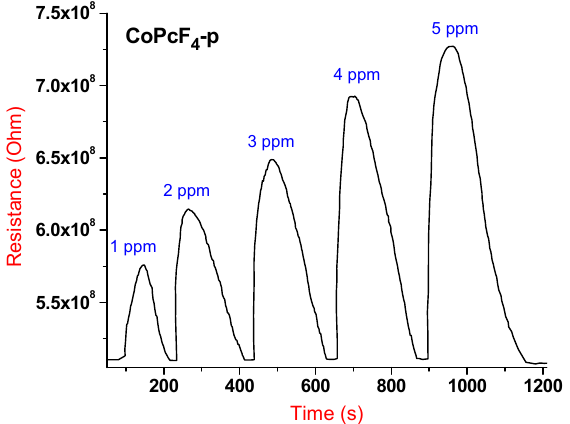
Figure 5. Typical chemiresistive sensor response of a CoPcF 4 -p film to ammonia (1–5 ppm), measured at room temperature.